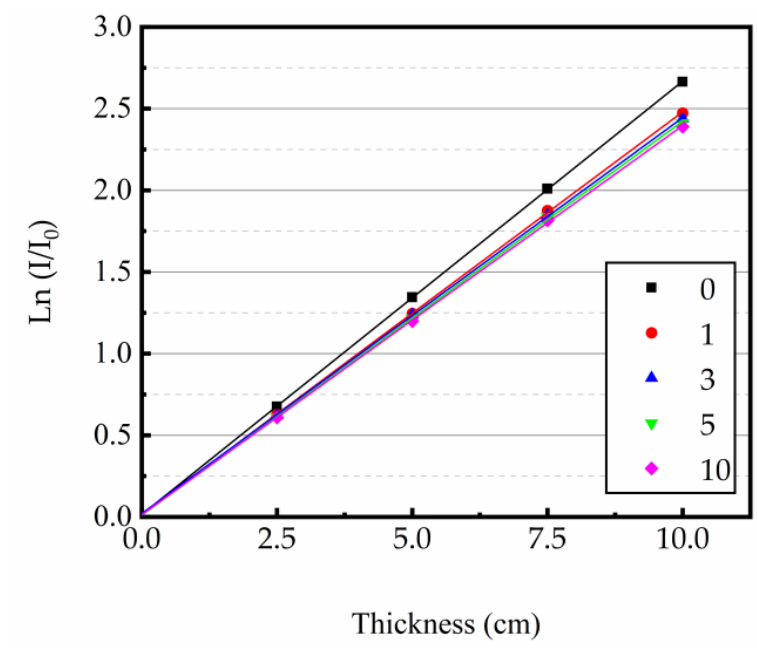
Figure 10. Relationship between ln(I/I 0 ) and concrete thickness at 300 °C.